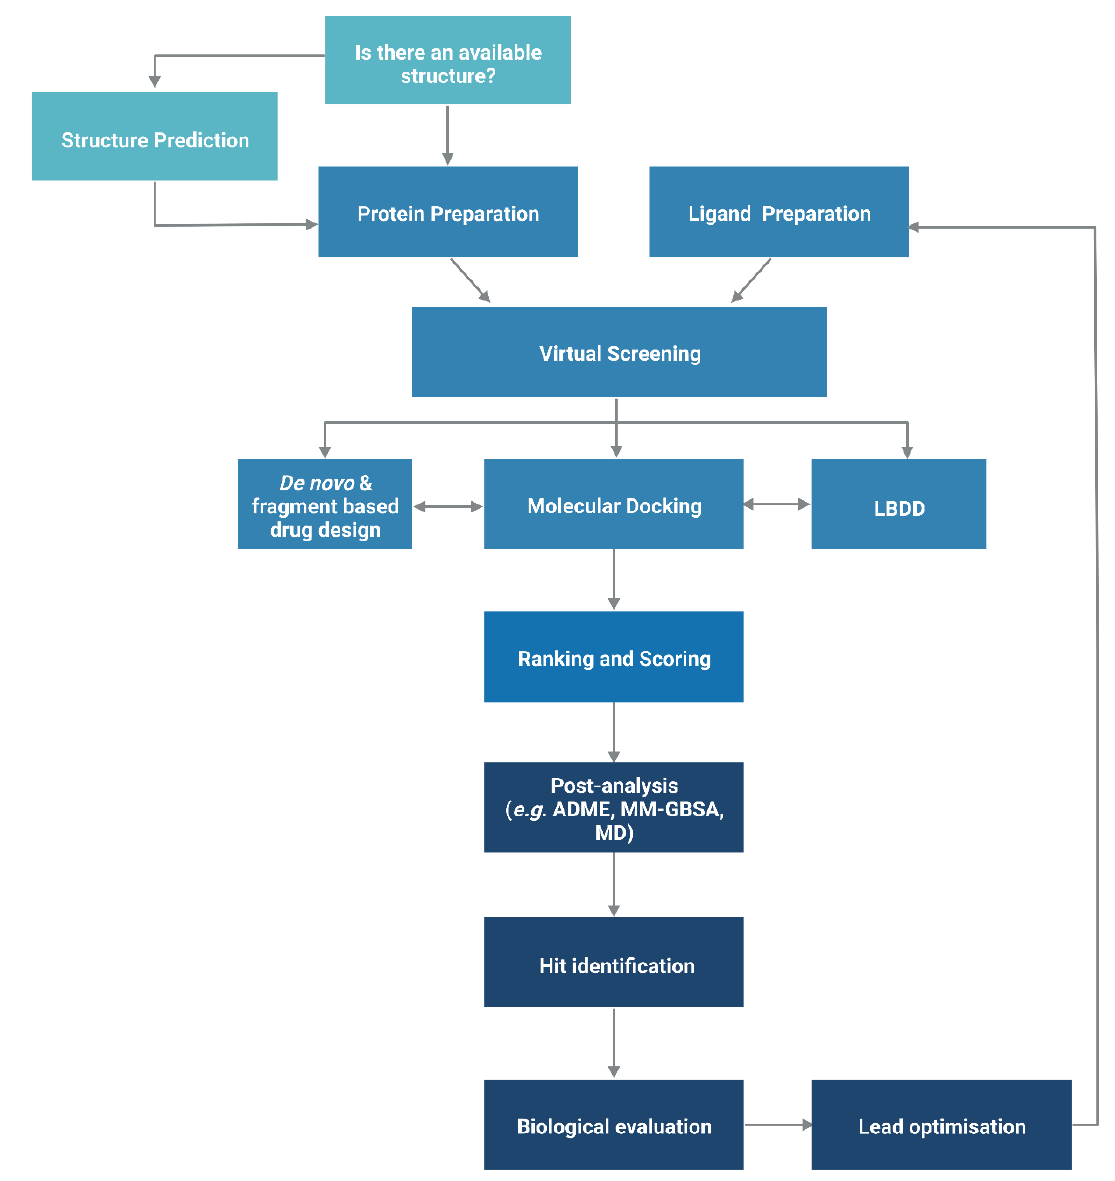
Figure 3. General workflow of molecular docking. The process begins with the preparation of the protein structure and ligand database separately, followed by molecular docking in which the ligands were ranked based on their binding pose and predicted binding affinity. (Abbreviations: LBDD: Ligand-based drug design; ADME: absorption, distribution, metabolism and excretion; MD: molecular dynamics; MM-GBSA: molecular mechanics with generalised Born and surface area).